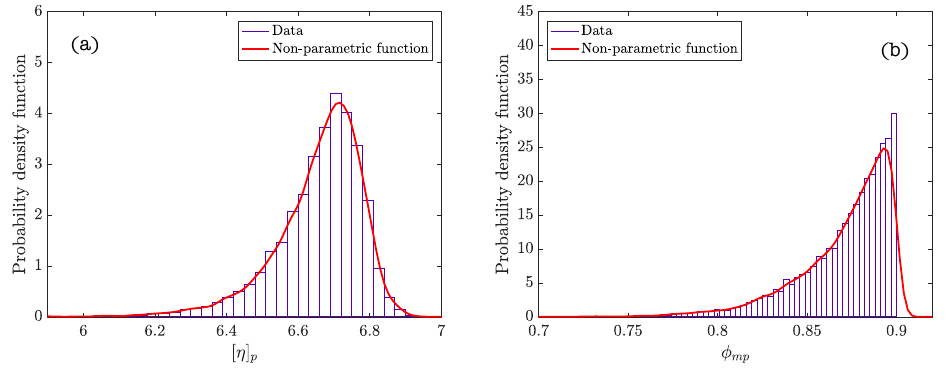
Figure 5. Density functions of probability of the parameters of the cement paste suspensions: ( a ) [ η ] p ; ( b ) φ m p .